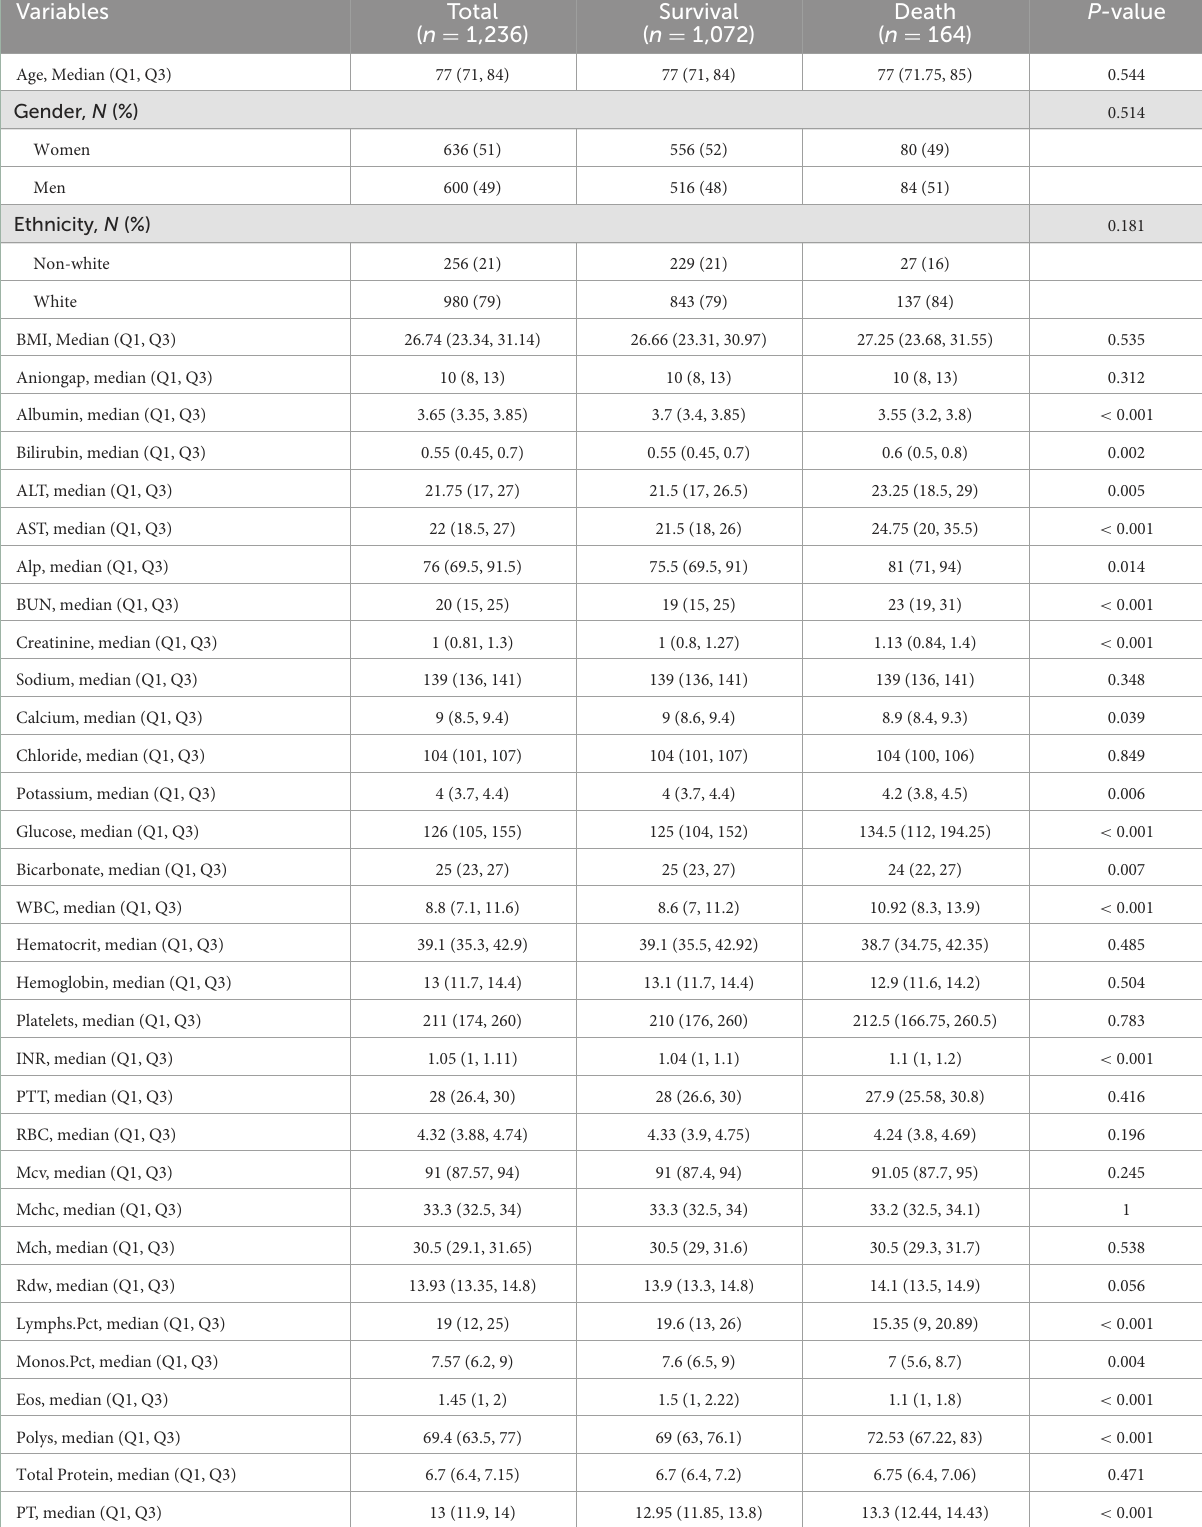
TABLE 1 The population demographics and clinical